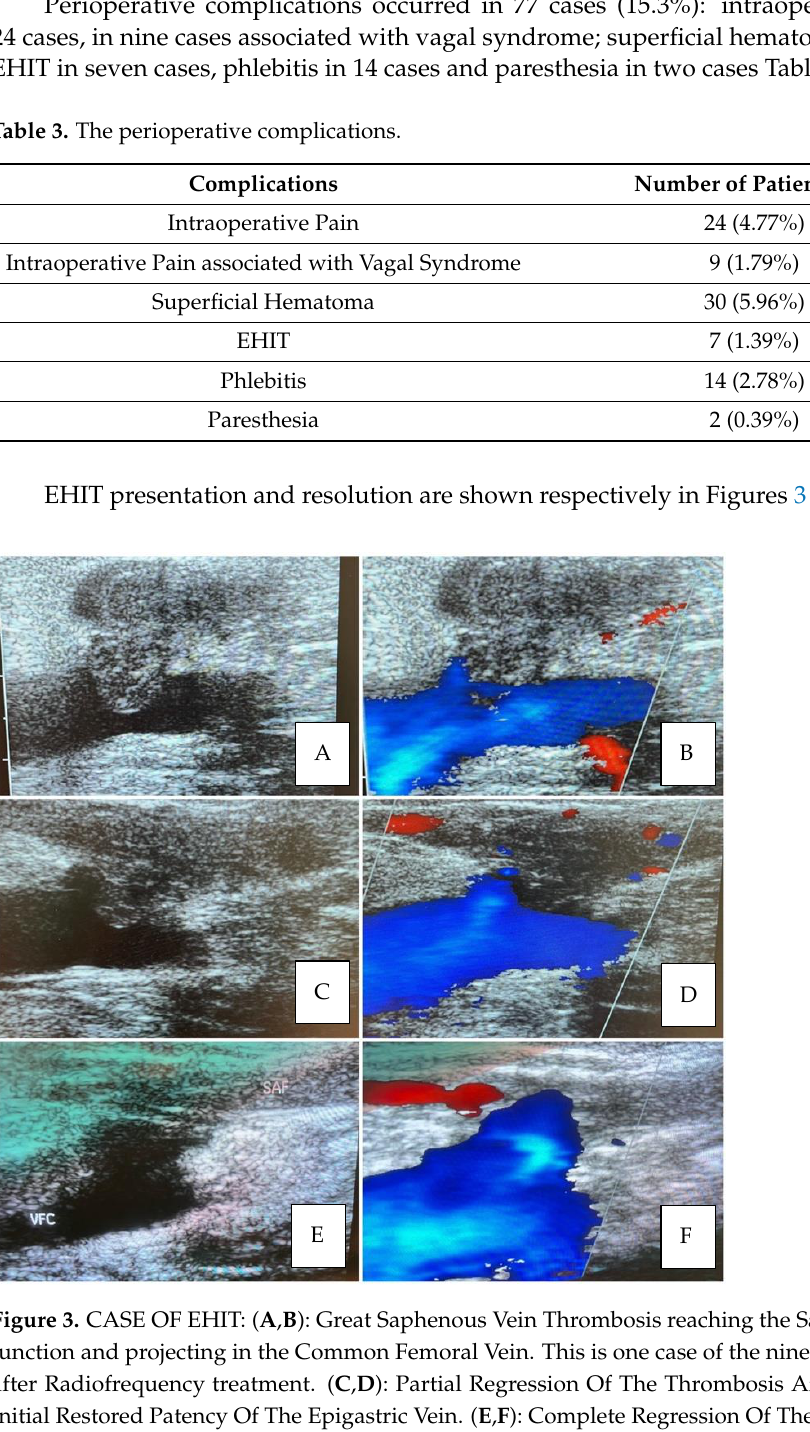
181 Figure 4. Post-operative obliteration of the Great Saphenous Vein, about 2 cm before the confluence 182 in the SF junction with patency of the epigastric vein. 183